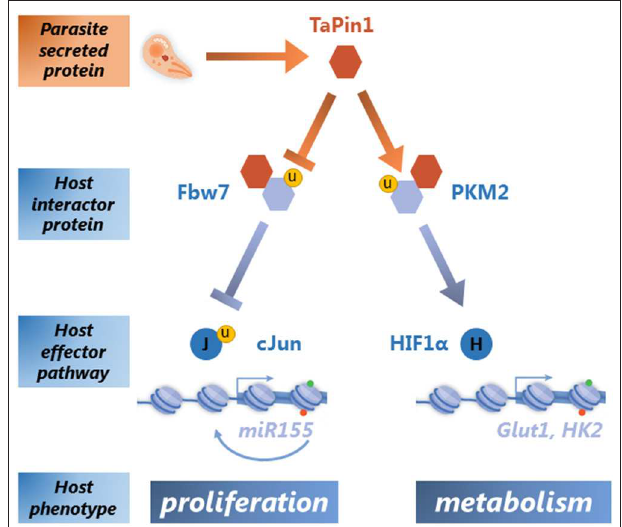
FIGURE 1 | Secreted TaPin1 isomerase regulates host signaling pathways leading to proliferative and metabolic phenotypes. A schematic representation of the role of the secreted TaPin1 molecule in host-parasite interactions. Theileria parasites (represented in orange) secrete TaPin1 proteins into the host cell (represented in blue). The TaPin1 interacts with two host signaling pathways: by destabilizing the Fbw7 ubiquitin ligase, TaPin1 activates the c-Jun transcription factor leading to regulation of proliferative genes such as the onco-miR-155 (Marsolier et al., 2013, 2015); in contrast, TaPin1 stabilizes the host PKM2 protein which drives host cell metabolic genes through the transcription factor HIF1 α (Medjkane et al., 2014; Marsolier et al., 2019). The yellow circle indicates the importance of ubiquitination in the TaPin1-regulated